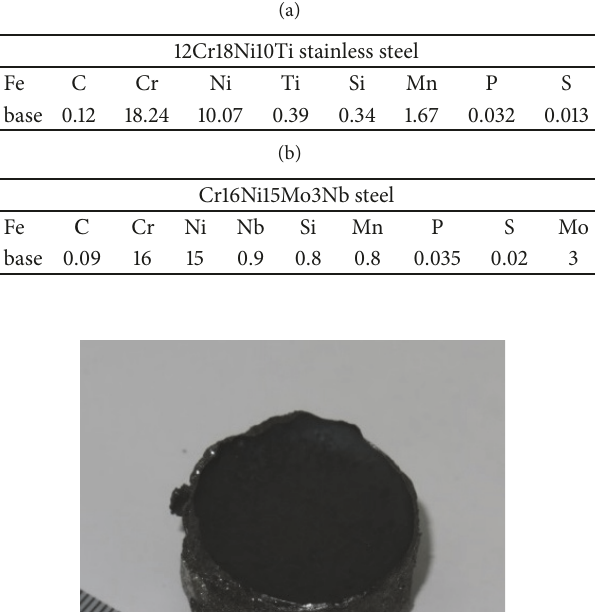
Table 1: The chemical composition of the used steels (wt. %).